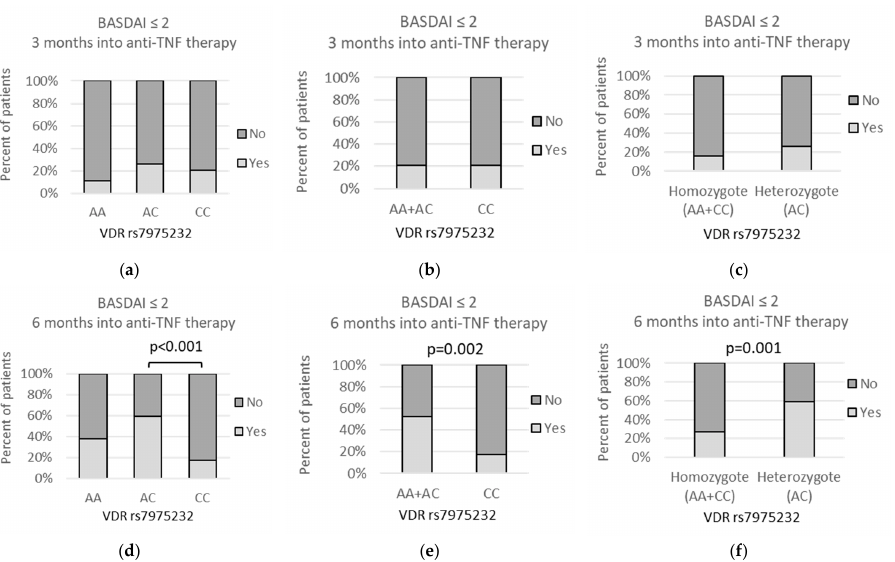
Figure 10. Relationships between VDR rs7975232 genetic variants and percent of patients achieving remission (BASDAI equal to or lower than 2 after ( a – c ) 3 months and ( d – f ) 6 months into the anti- TNF treatment. Prior to the therapy, BASDAI scores were above 4 for all the patients; therefore, this time point was not included in the current analysis. The following statistically significant associations were found after 6 months of the therapy: ( d ) AC vs. CC , p < 0.001, OR(95%CI) = 6.96 (2.30 to 18.52); ( e ) AA + AC vs. CC , p = 0.002, OR(95%CI) = 5.20 (1.75 to 13.4); and ( f ) AA + CC vs. AC , p = 0.001, OR(95%CI) = 0.26 (0.11 to 0.60). Analysis was performed using Fisher‘s exact test. The VDR rs7975232 A allele was further related to improvement in BASDAI after 6 months of anti-TNF treatment under the recessive model ( AA + AC vs. CC : 30/75 (40%) vs. 4/29 (13.8%); p = 0.011). Furthermore, the over-dominant model ( AA + CC vs. AC : 11/55 (20%) vs. 23/49 (46.9%); p = 0.006) and codominant model ( AC vs. CC : 23/49 (46.9%) vs. 4/29 (13.8%); p = 0.003) showed that AC genotype was related to BASDAI improvement of ≥ 75%. The above-described associations are depicted on Figure 11.